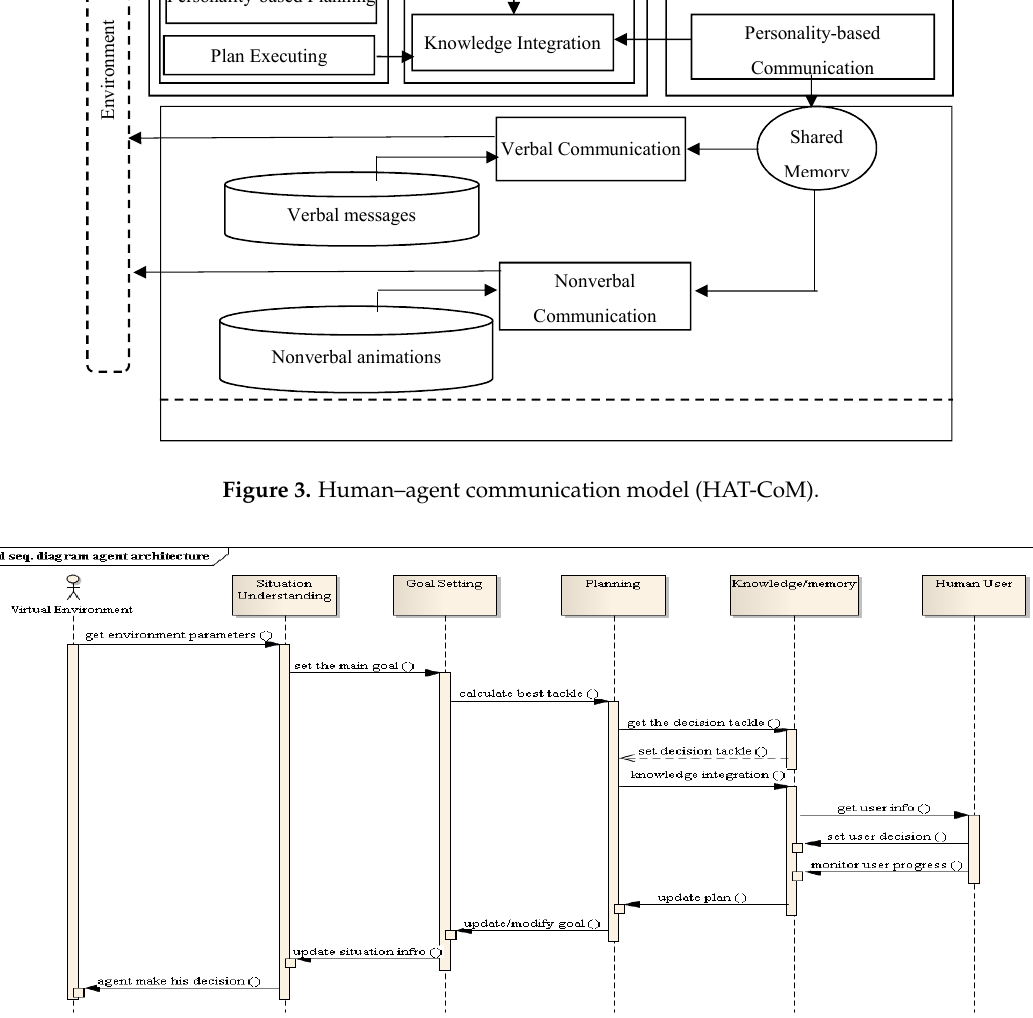
Figure 4. Flow between the modules in the agent architecture.